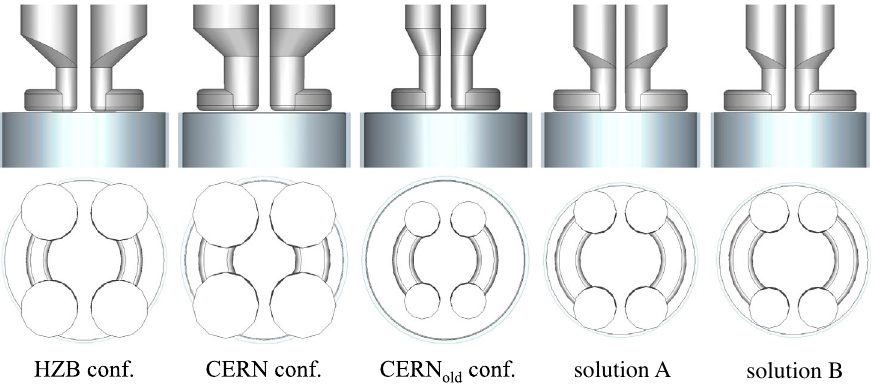
FIG. 9. Comparison between the shape of the HZB design, CERN designs, and the obtained